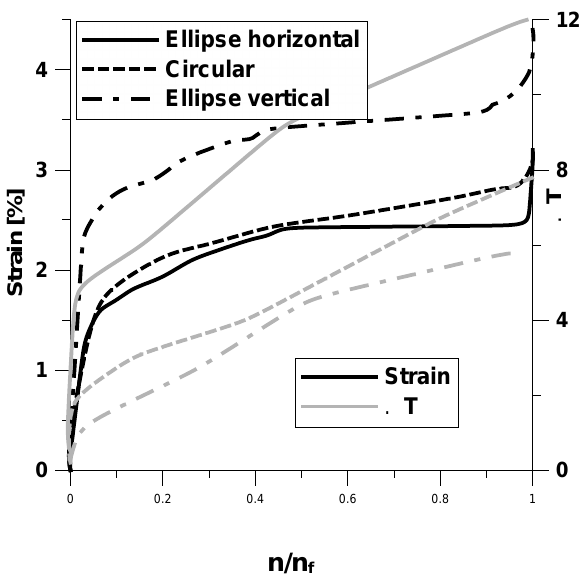
Figure 15. Global fatigue deformations of the plate with the vertical elliptical hole.